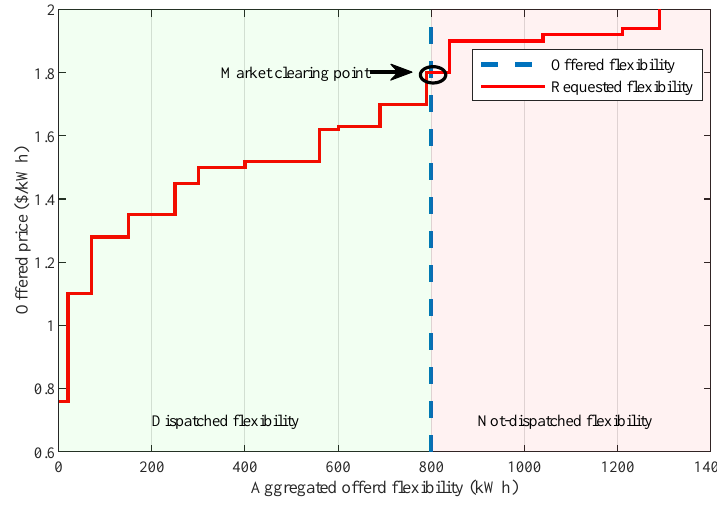
Figure 9. Auction-based approach.